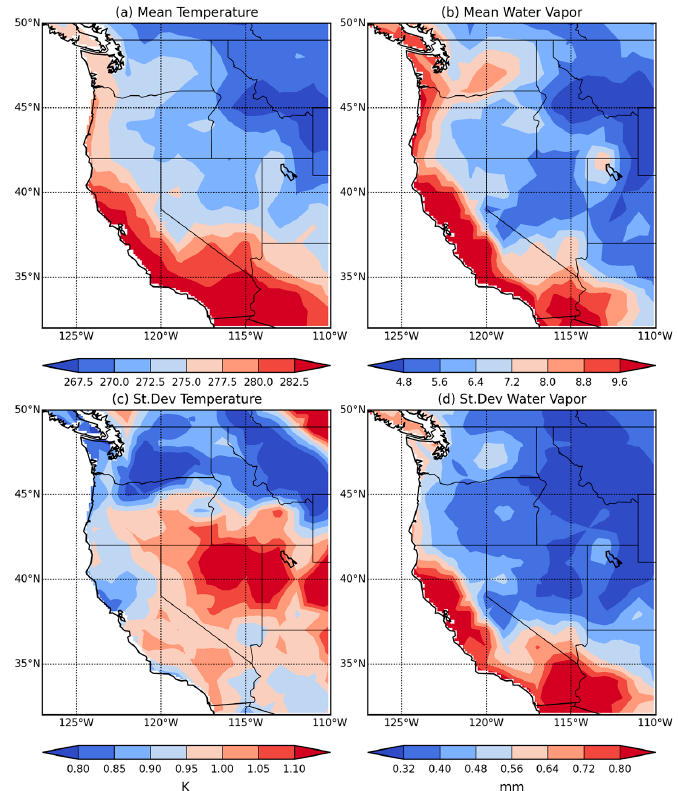
Figure 5. The mean ( a ) surface temperature and ( b ) integrated water for the winter season between 2003 and 2016. The standard deviation from the mean for the ( c ) surface temperature and ( d ) integrated water vapor.